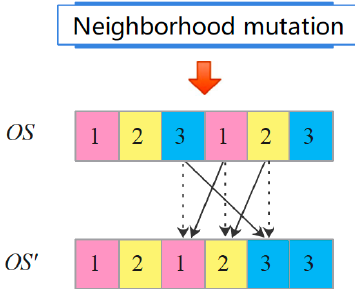
Figure 7. Example of three job mutation.